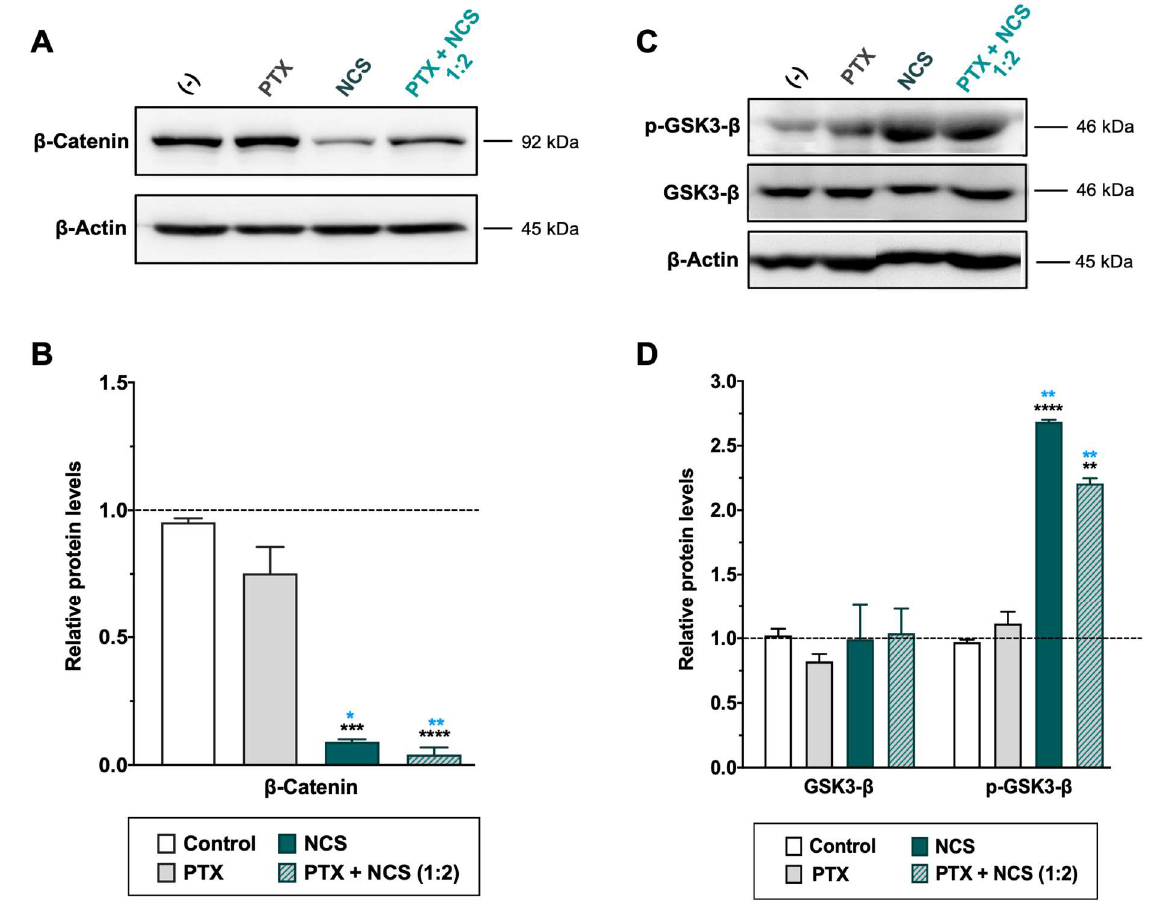
Figure 8. Effect of NCS and PTX treatments in the Wnt/β-Catenin signaling pathway in MDA-MB- 231 cells. β-Catenin, total- and phosphorylated-GSK3-β protein levels expression levels after PTX and NCS treatment, both alone and in combination (1:2 ratio), were determined. ( A – C ) Representative β-Catenin and GSK3-β protein levels after drug treatments. The β-actin protein expression level was used as a loading control. ( B – D ) Graphs represent the quantification band intensity signal referred to β-actin expression, represented as mean ± SEM of three independent experiments. Statistic t -test analysis of NCS and combined therapy was performed in comparison with control non-treated cells (black asterisks, ** p < 0.01 and **** p < 0.0001) as well as with PTX treatment (blue asterisks, * p < 0.05 and ** p < 0.01).